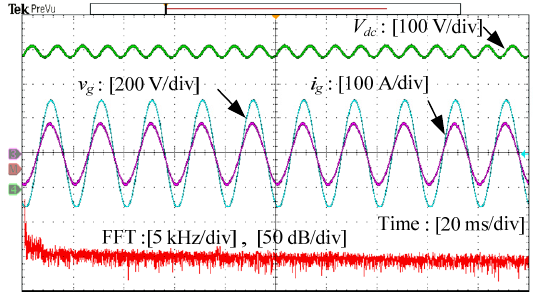
Figure 16. Experimental results of the HSTT with an IFI-based LCL-type filtered single-phase converter.